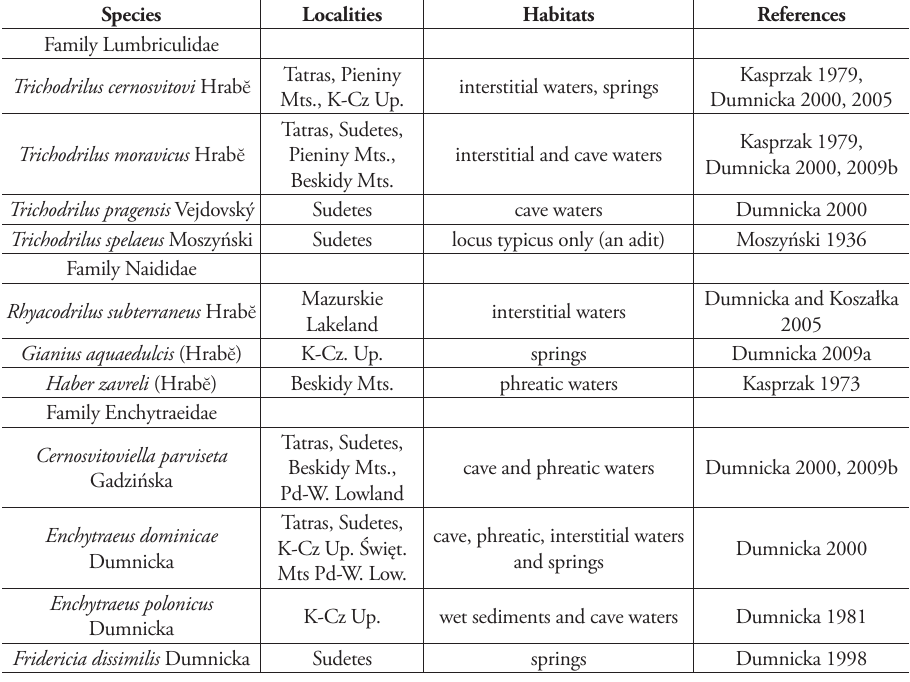
Table 1. Distribution of stygobitic oligochaetes in Poland. Species Localities